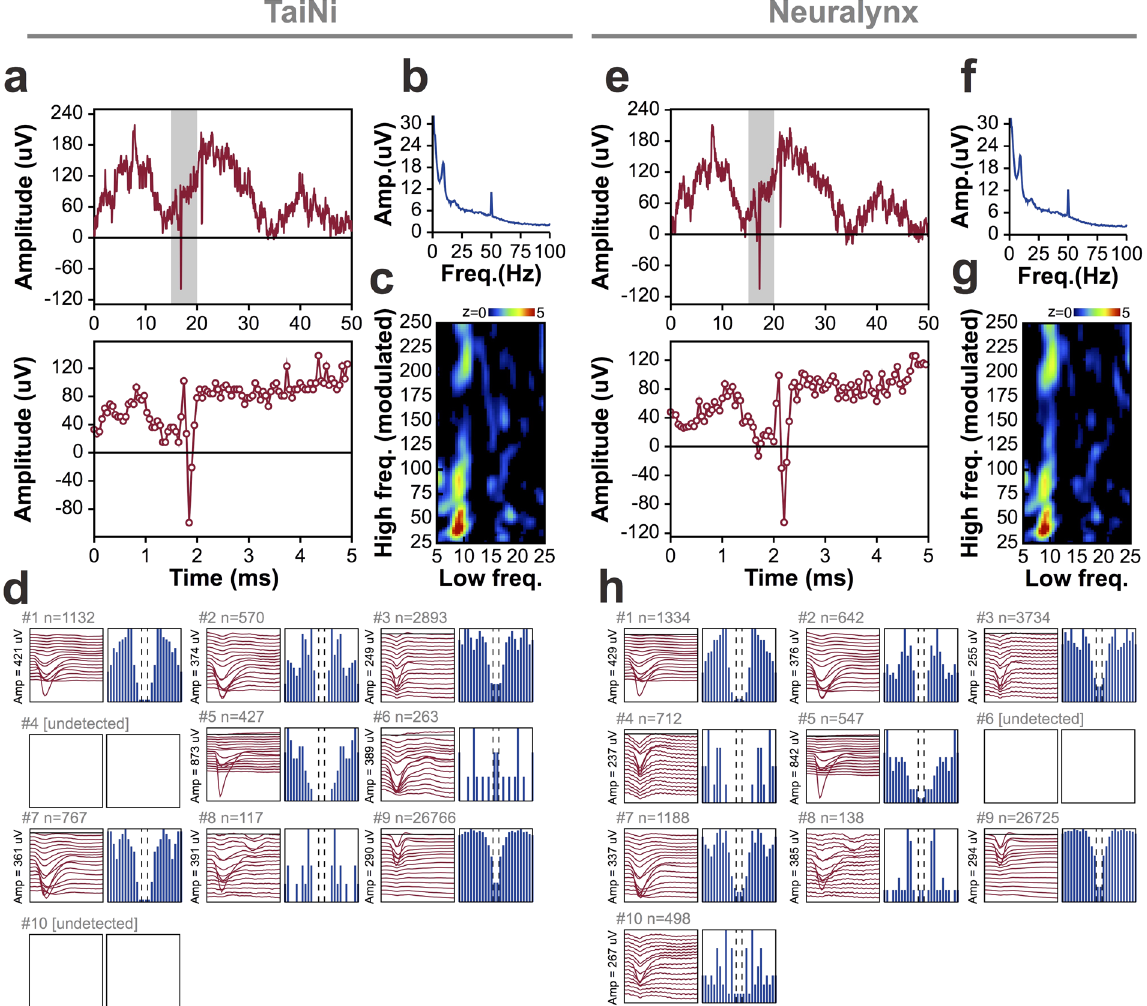
Figure 6. Comparison between the wireless TaiNi system (left) and a Digital Neuralynx tethered system (right). Data was split at the connector on the mouse’s head and fed to both systems simultaneously for comparison. ( a , e ) Matching raw traces as processed by the two systems, highlighting action potentials and theta oscillations. Bottom panels are enlarged views of the grey zone in the top panel. ( b , f ) Power spectra for the entire 10-minute recording. ( c , g ) Phae-amplitude coupling analysis, showing clear modulation of the amplitude of gamma (centred at ~37 Hz) by the phase of theta (centred at ~8 Hz) oscillations. ( d , h ) Comparison of spike-sorting results from the two systems, with identified cells (clusters) represented by their mean action-potential depth- profile (red traces) and their autocorrelograms (in blue). The display topographical with the same putative cell occupying the same position in ( d ) and ( h ). TaiNi tends to detect somewhat fewer spikes overall, and both systems sometimes identify clusters not found by the other. Overall however, the results are quite